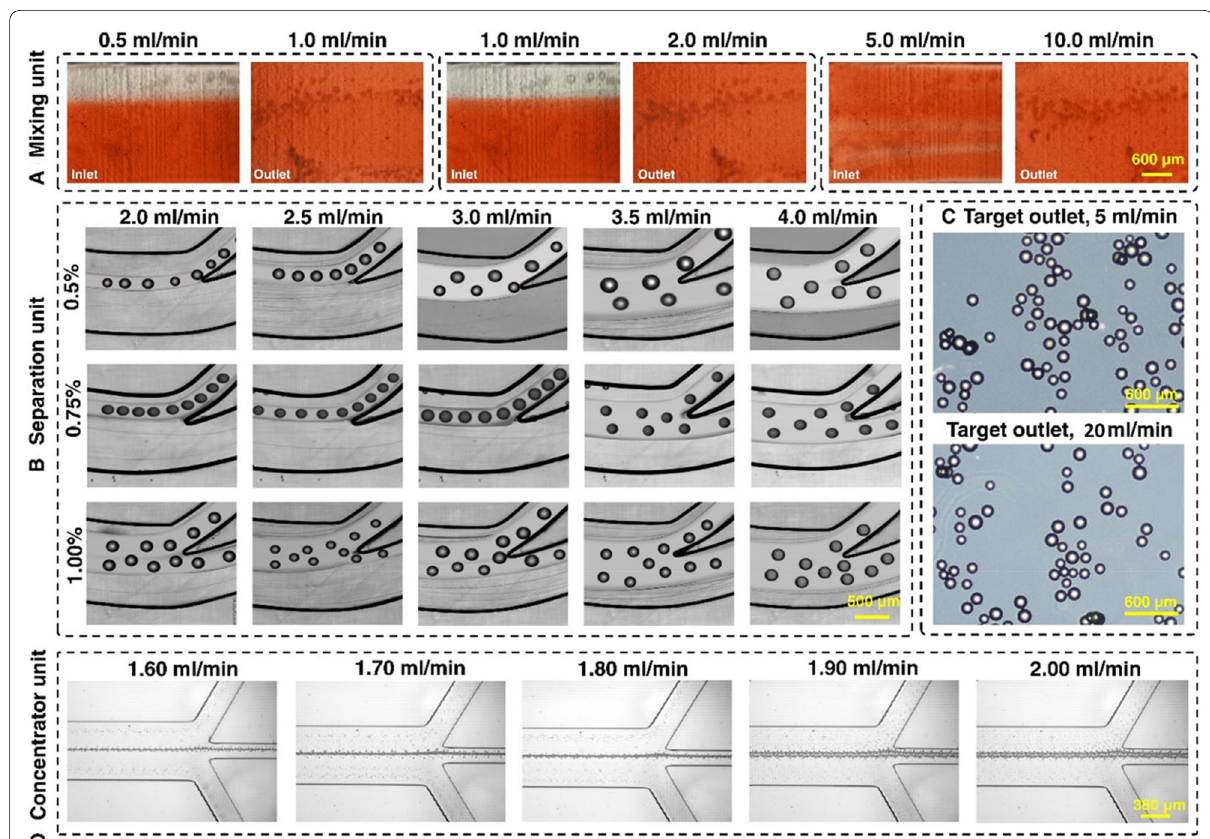
Fig. 2 Characterisation of the microfluidic harvesting system using food dye, MCs, and fluorescent microparticles. A The micromixer reached 95% mixing efficiency with a 1:2 fluid flow mixing ratio. B The spiral microfluidic device can be operated at a flow rate of 3 mL/min with 0.75% v/v% microcarrier concentration. C The micromixers and spiral apply gentle forces to the microcarriers, and no breakage of microcarriers happened even when the flow rate was 6 times higher than the operation flow rate. D The zig-zag channel focuses 15 um beads from 1.6 to 2 mL/min with a 100% recovery